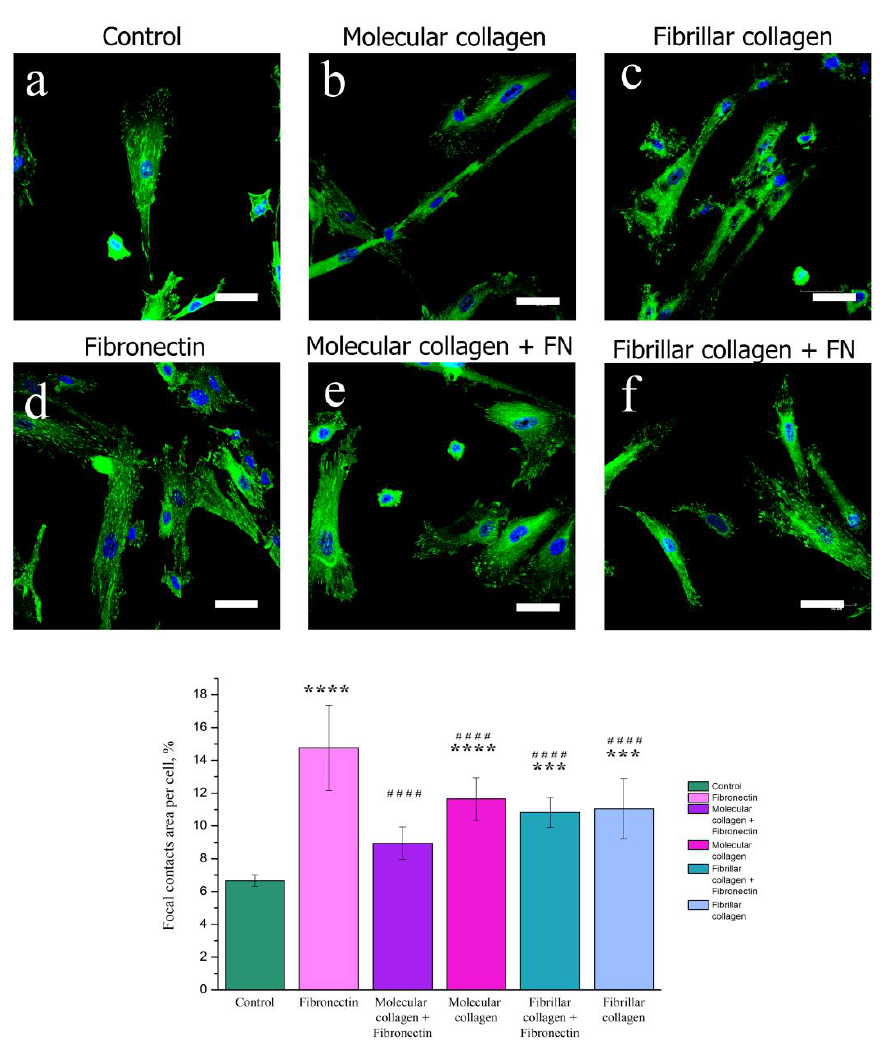
Figure 5. Fluorescence micrographs of MSCWJ-1s with vinculin (green) and nuclei (blue) stained after one days of cultivation on molecular and fibrillar collagen with/without fibronectin (FN): control (cover glass) ( a ), molecular collagen ( b ); fibrillar collagen ( c ); fibronectin ( d ); molecular collagen + fibronectin ( e ); fibrillar collagen + fibronectin ( f ). Statistics of cell adhesion on molecular and fibrillar collagen with/without fibronectin after 1 day cultivation. (n = 7–12: ****— p < 0.0001 and *** — p < 0.001 compared with the control, #### — p < 0.0001 compared with the fibronectin). Scale bar 50 µm.